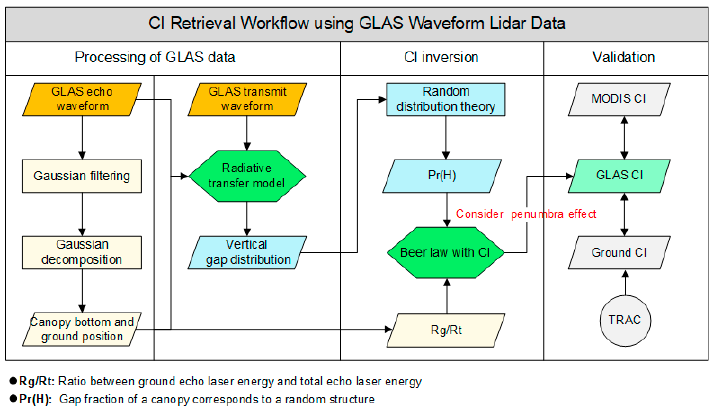
Figure 2. Workflow diagram for retrieving clumping index (CI) from GLAS data.